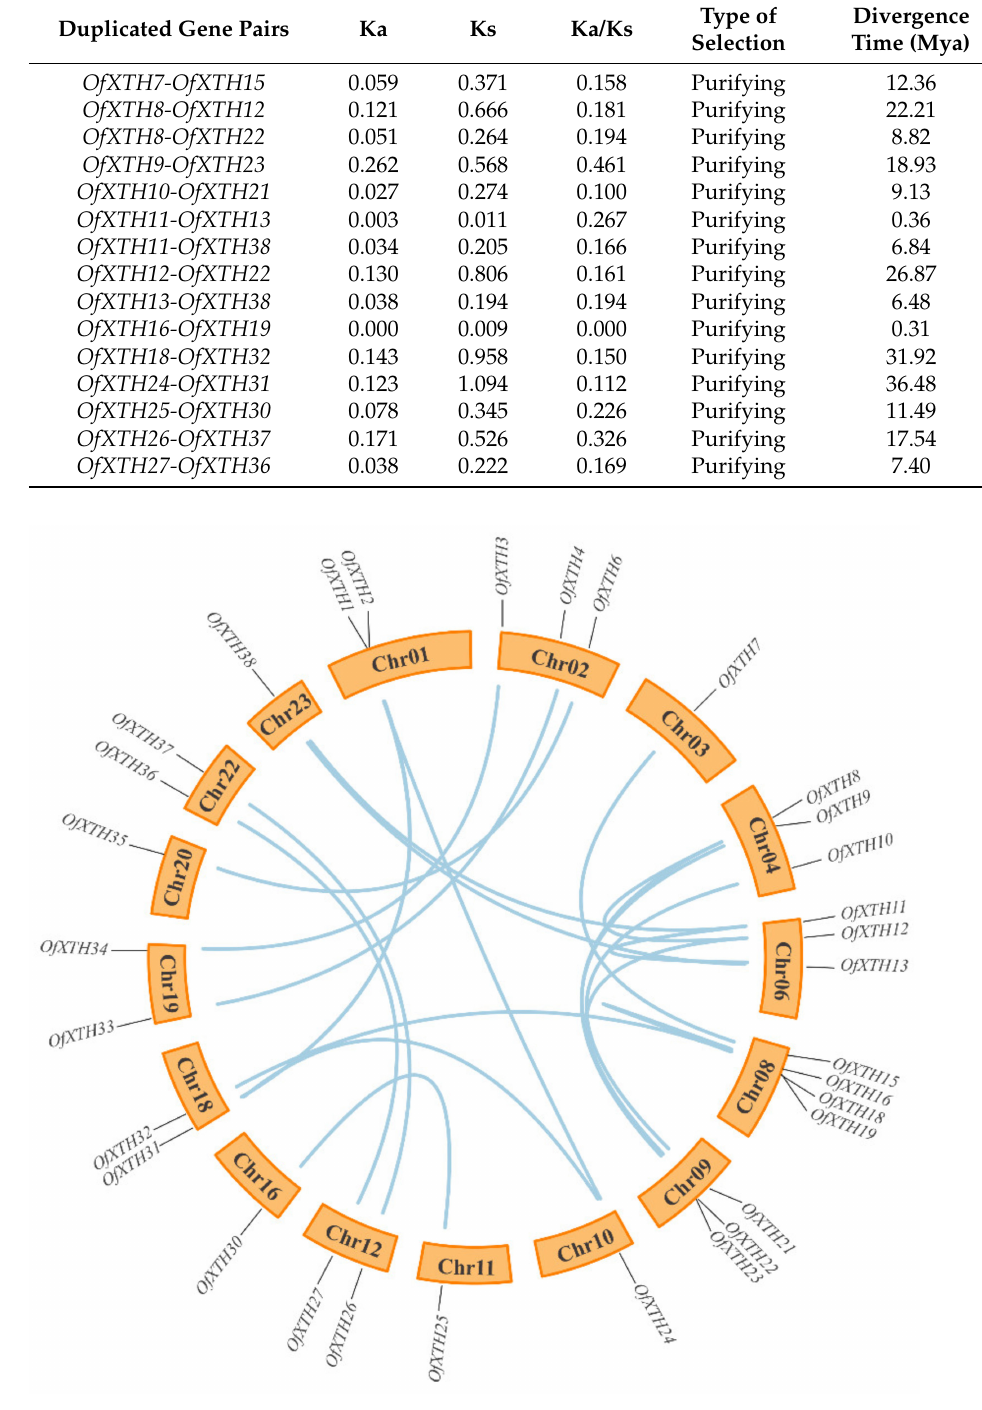
Figure 4. Synteny analysis of 38 OfXTH genes in O. fragrans . Orange rectangles represent chromo- somes of O. fragrans , and blue lines represent segment duplicate gene